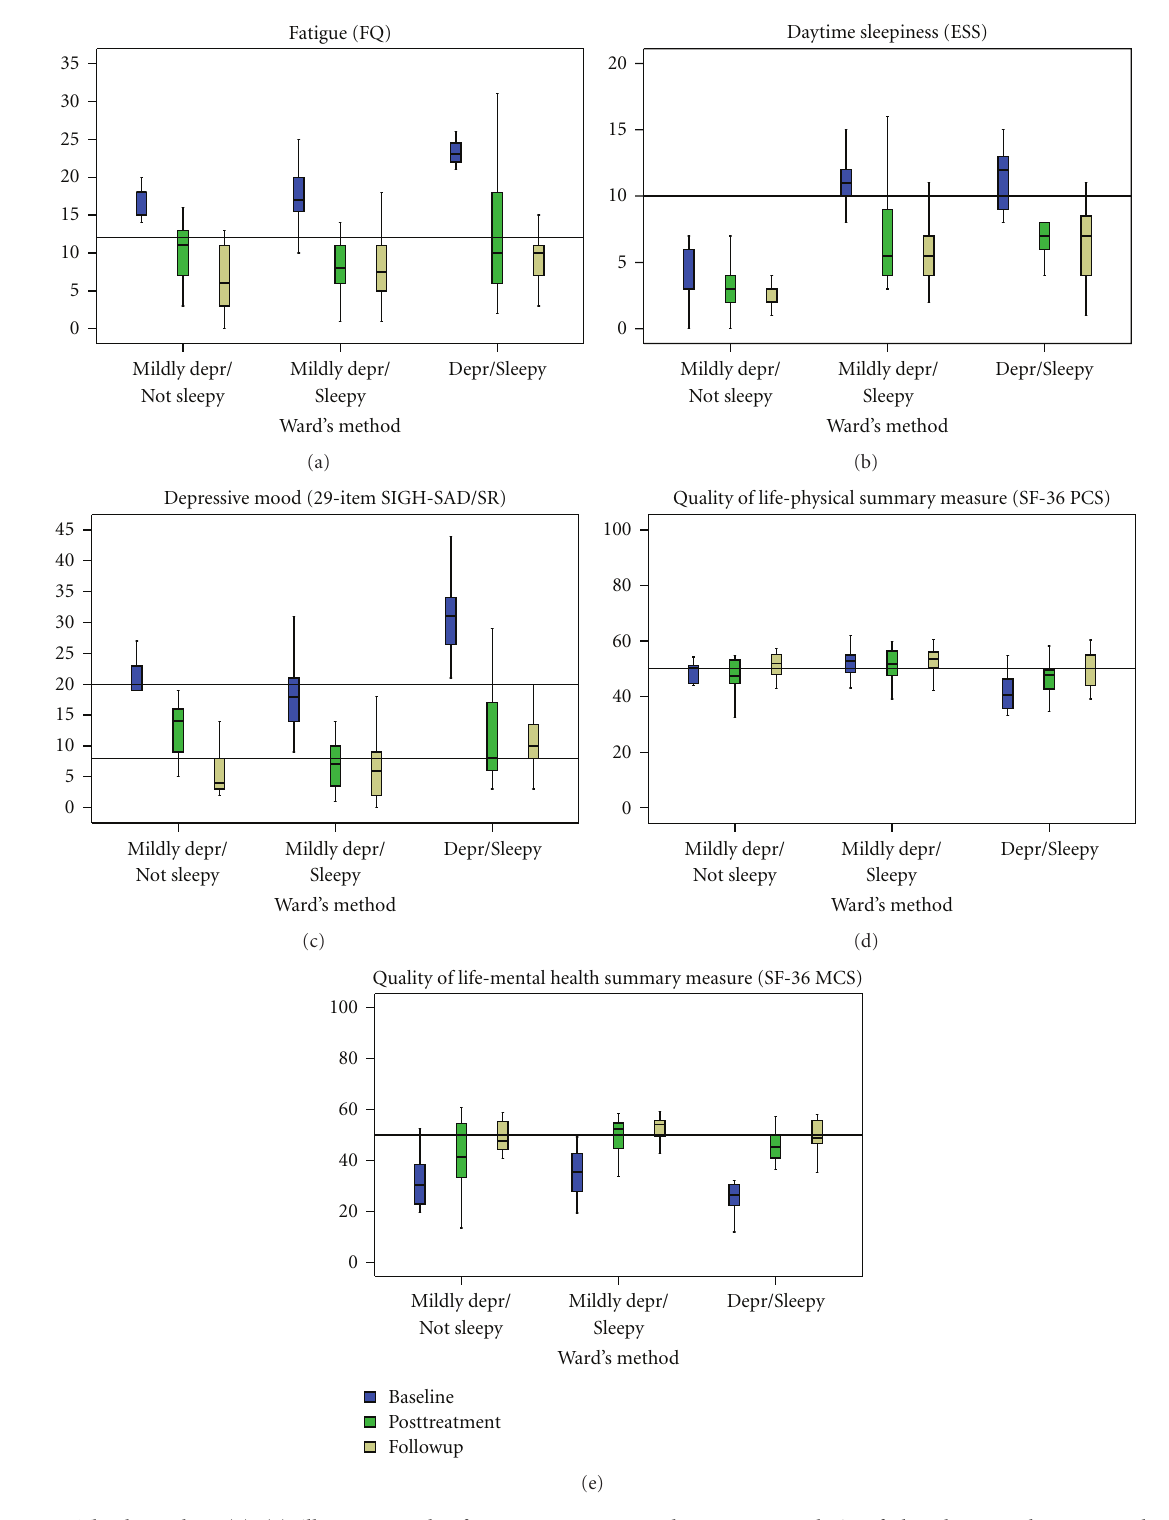
Figure 2: The box plots (a)–(e) illustrate results from ANOVA repeated measures analysis of the clusters/subgroups at baseline, posttreatment, and one-monthfollowup. A reference (horizontal)line isgiven for each measure; the fatigue questionnaire (FQ), a population mean set at 12.2 [25] and the Epworth Sleepiness Scale (ESS), a cuto ff for excessive daytime sleepiness set at ≥ 10 [26]. Two reference lines are given for the 29-item SIGH-SAD/SR depression scale, one representing scores for individuals without depressive symptoms set at ≤ 8 [31] and the other indicating possible depression set at ≥ 20 [32]. The reference lines for the SF-36 PCS (physical component summary scale) and MCS (mental component summary scale) represent mean values for the general population set at 50